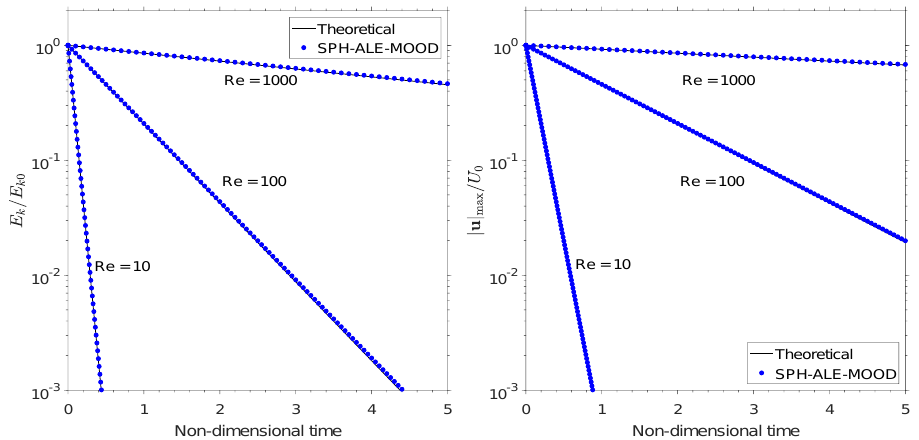
Figure 11. Taylor Green flow: Comparison of the numerical and theoretical decay of the kinetic energy factor defined in Equation (15) ( left ) and the maximum velocity ( right ) for Re = 10, Re = 100 and Re =